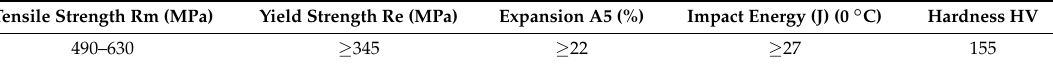
Table 2. Mechanical properties of steel S 355J0WP.